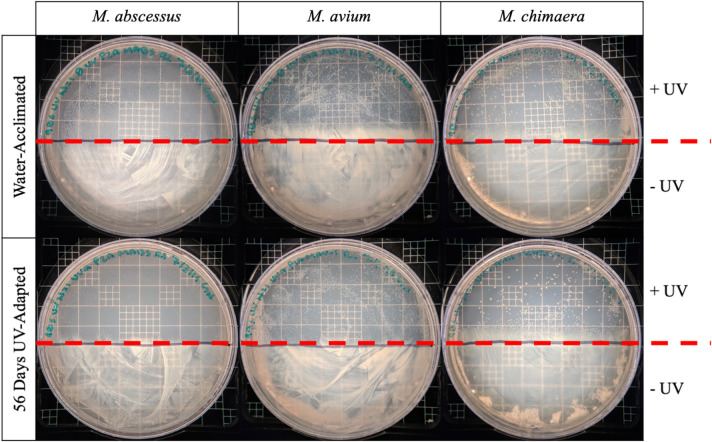
Repeated UV exposure does not affect the susceptibility of NTM to UV-C. The sensitivity to UV-C treatment between unexposed (water acclimated, top row) M. abscessus, M. avium, and M. chimaera and 56-day UV-adapted M. abscessus, M. avium, and M. chimaera (56-days UV-adapted, bottom row) were compared for their ability to survive 90 s of UV-C irradiation. One hundred microliter of bacterial stock was spread onto 7H10 agar plates. Half of the plate was covered with by notecard to protect against UV-exposure and the other half was exposed directly to 254-nm UV-C light for 90 s. Plates were incubated at 37°C and the growth of the UV-C treated (above red line) and untreated (below red line) regions were visually compared.